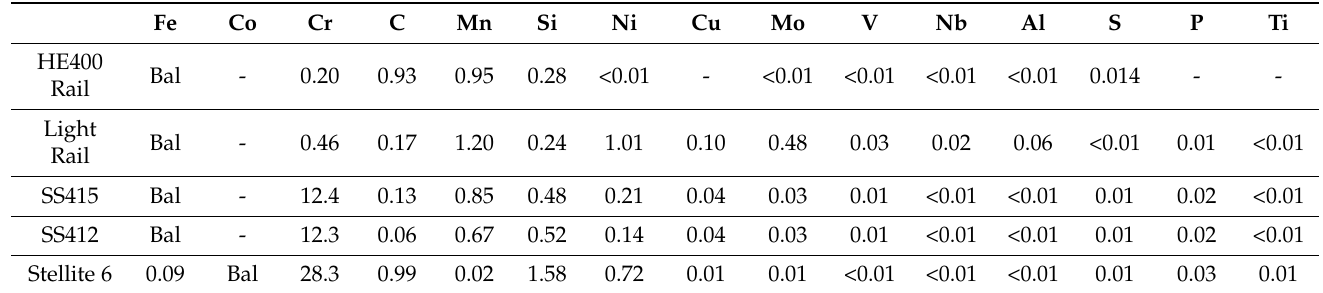
Table 1. Chemical composition (wt.%) of the rail substrates and cladding alloys.